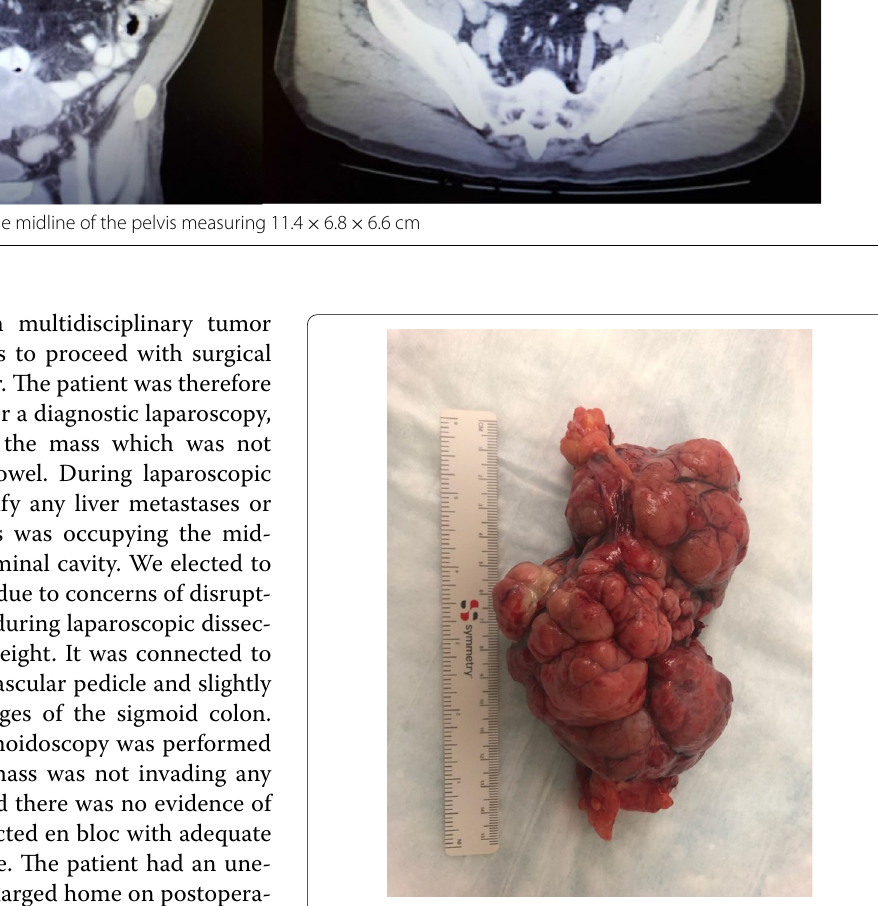
Fig. 2 Tumor after complete surgical resection, encapsulated bosselated